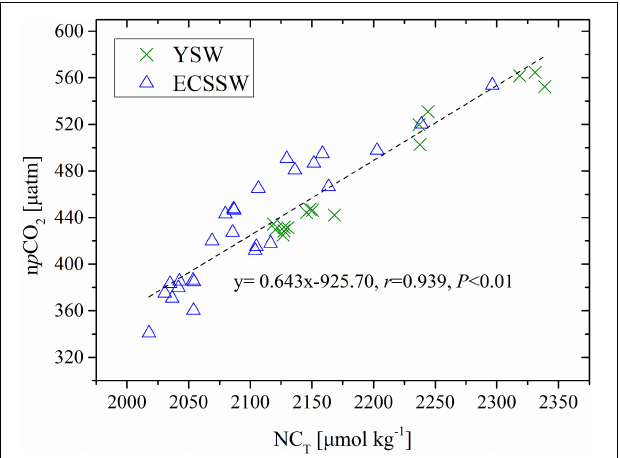
FIGURE 8 | Correlation of surface p CO 2 normalized to the average temperature of 22.75 ◦ C in October (n p CO 2 ) and salinity normalized C T (NC T ).